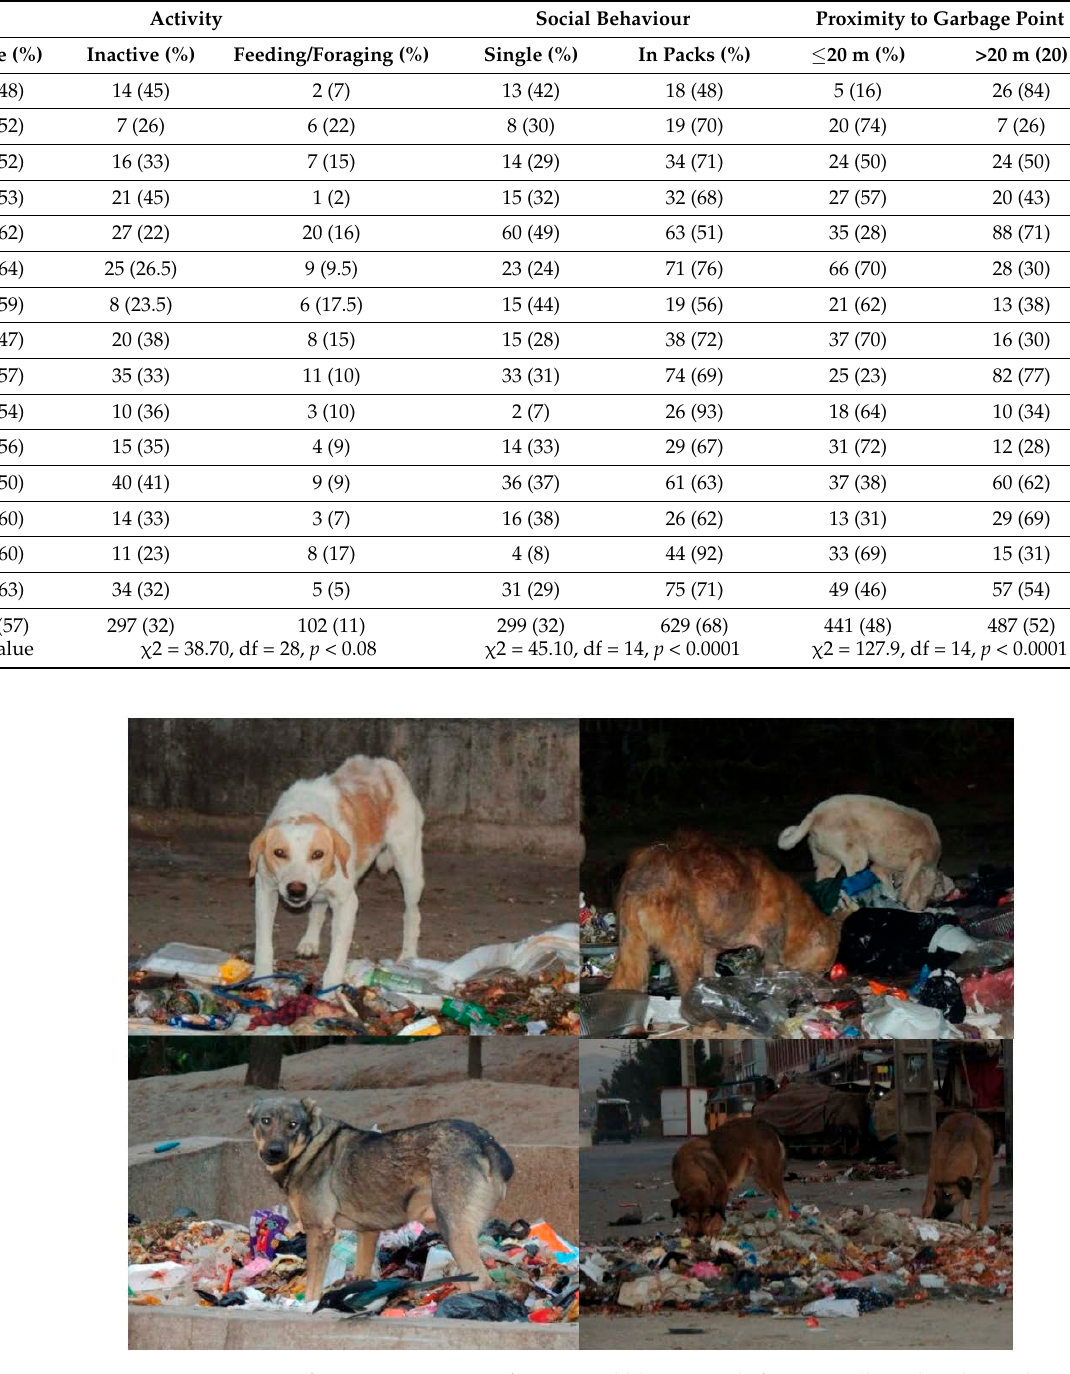
Table 4. Details of activity, social behaviour and sightings within 20 m of garbage points for FRDs sighted across fifteen districts of Herat city .